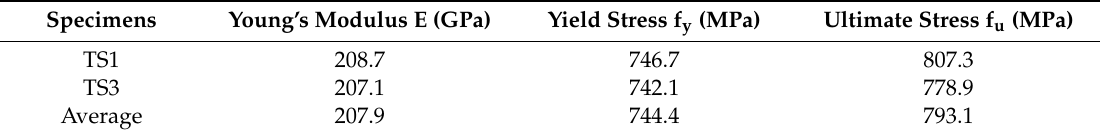
Table 3. Basic mechanical properties of BS700 high-strength steel.